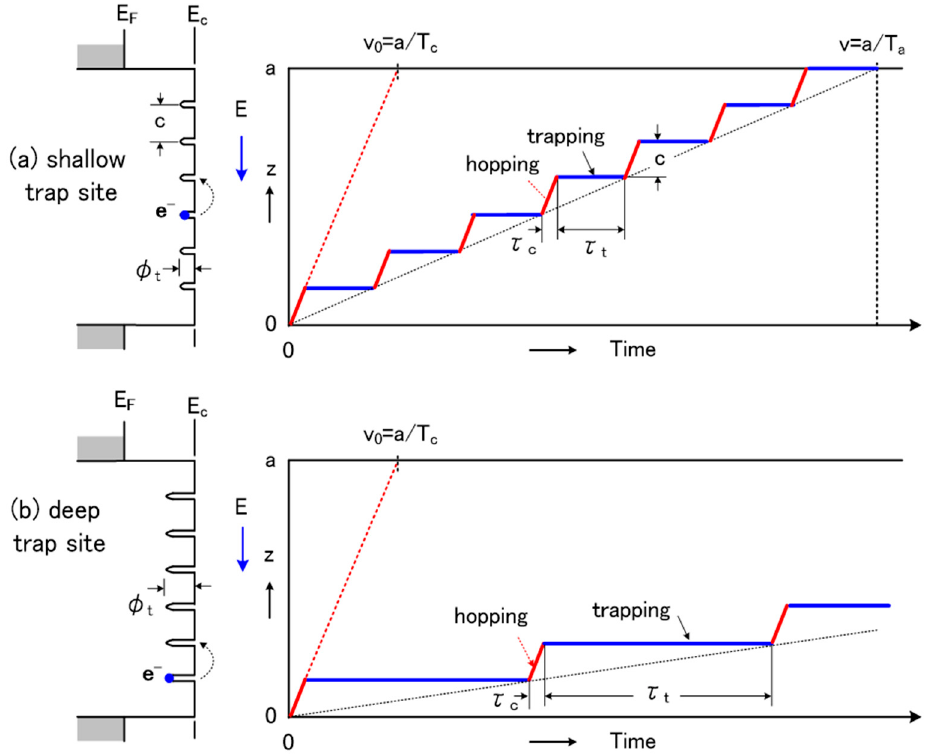
Figure 3. Relationship between carrier hopping process and trap sites. ( a ) Carrier hopping process for the shallow trap site; ( b ) Carrier hopping process for the deep trap site.